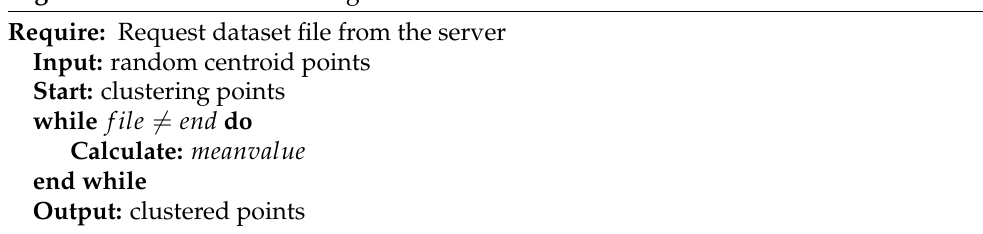
Algorithm 2 k-means clustering on mobile